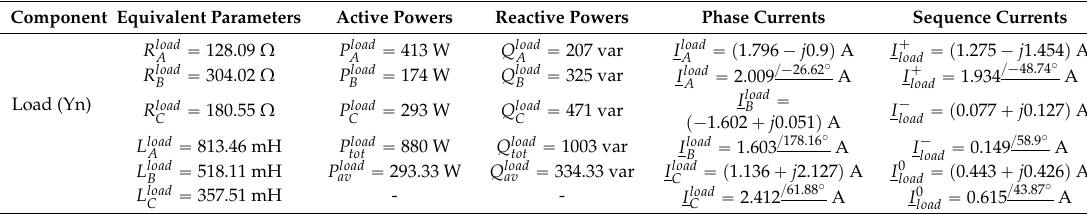
Table 1. The unbalanced three-phase load.